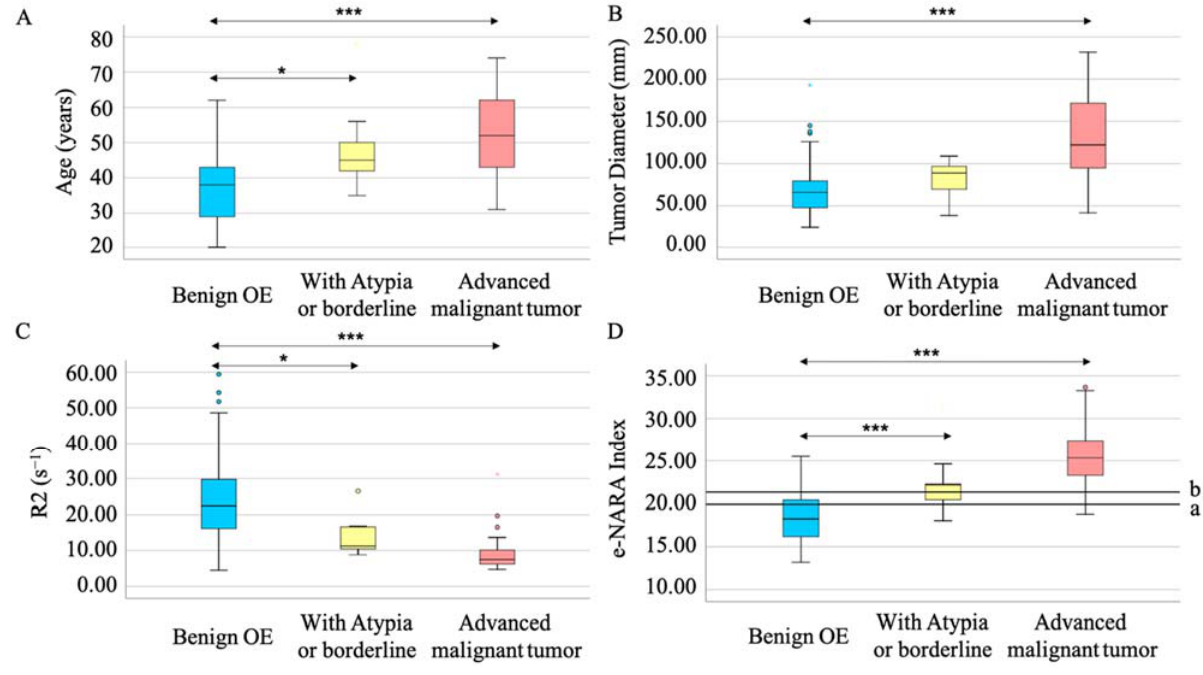
Figure 3. The e-NARA index, which consisted of age ( A ), tumor diameter ( B ), and R2 value ( C ) could discriminate between atypia/borderline tumor from OE ( D - a ) and advanced malignant tumor from benign OE ( D - b ). Circles and stars represent outlier( B and C ). *** p < 0.001 and * p < 0.05 vs. benign OE. Table 6. The cut-off values among benign OE, atypia or borderline tumor, and advanced malignant tumor in the current